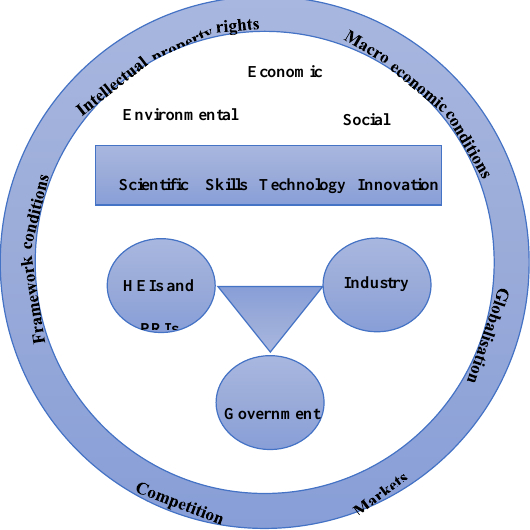
Figure 1. Illustration of the main actors and constituents in an innovation system. Source: adapted from OCDE, 2014.